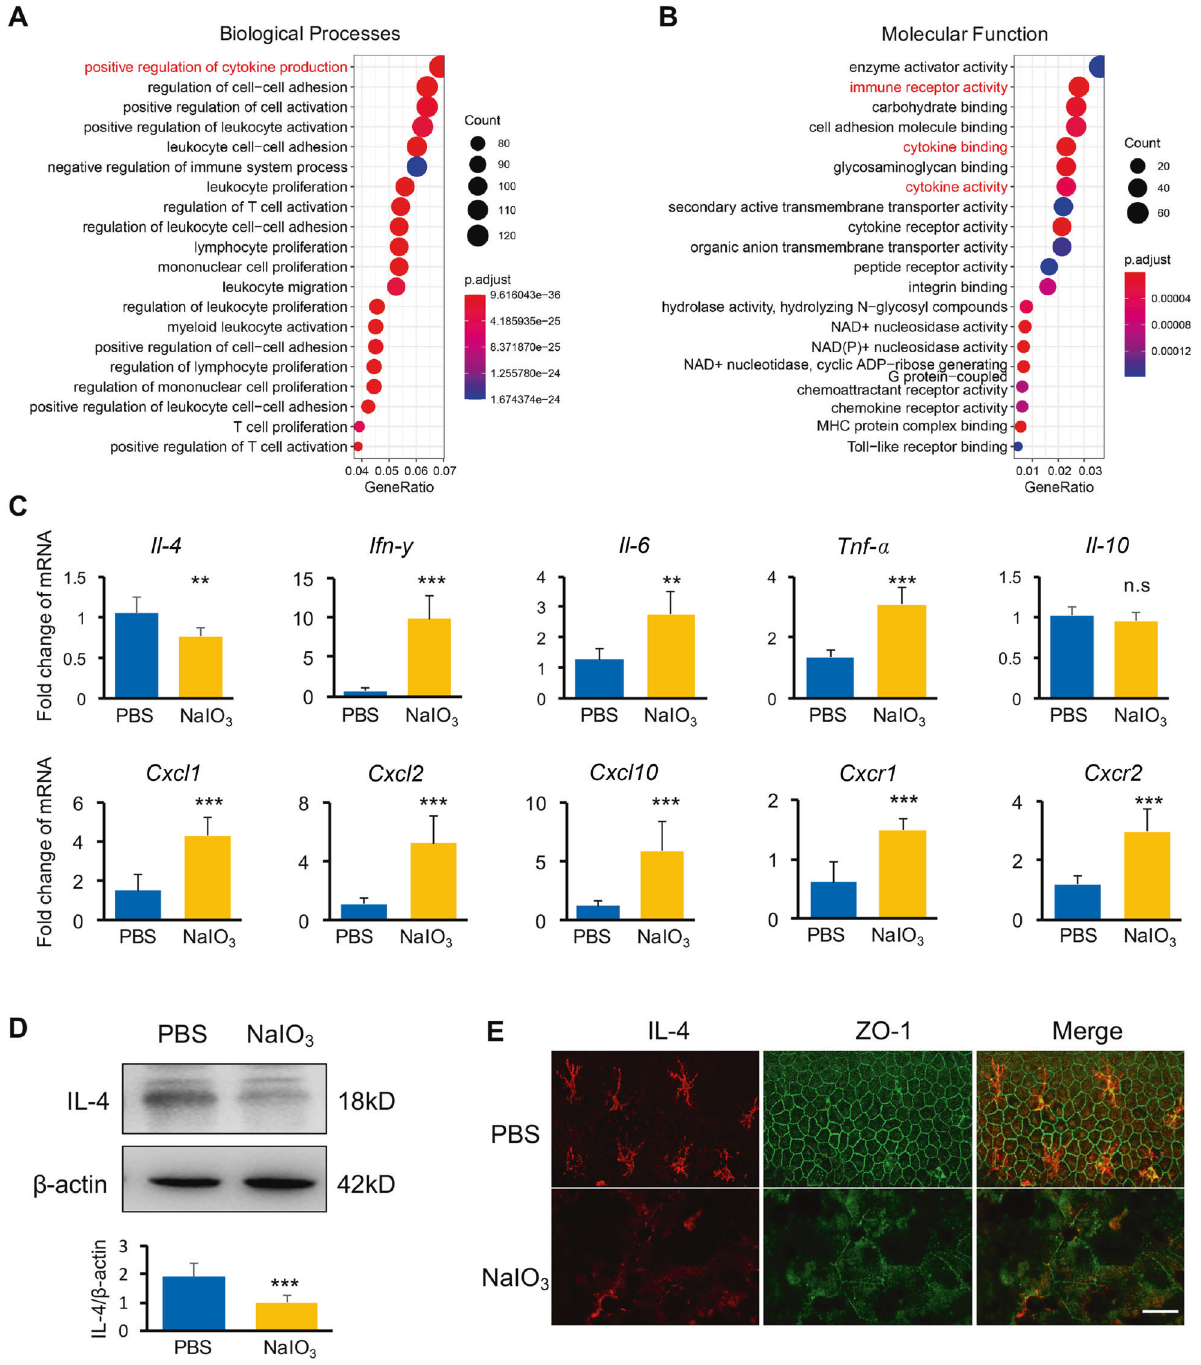
Fig. 1 NaIO 3 -induced degenerative retinae underwent in fl ammatory responses and displayed decreased IL-4 expression. A , B GO enrichment of the upregulated DEGseq in NaIO 3 -induced degenerative retinae showed the enriched differentially expressed mRNAs in biological processes ( A ) and molecular function ( B ). C qPCR analysis showed decreased mRNA levels of IL-4 in NaIO 3 -induced degenerative retina, while the pro-in fl ammatory cytokines and chemokines/chemokine receptors, including Ifn- γ , Il-6 , Tnf- α , Cxcl1 , Cxcl2 , Cxcl10 , Cxcr1 and Cxcr2 were signi fi cantly increased. The anti-in fl ammatory Il-10 had no signi fi cant difference between the NaIO 3 -induced retina and normal control, n = 3. D Western blotting analysis showed marked decreased IL-4 expression in the NaIO 3 -retinae in comparison to controls, n = 3. E Lack of IL-4 expression (red) and broken ZO-1-positive RPE barrier (green) were observed in the NaIO 3 -induced RPE fl at-mount sheet by immunohistochemistry analysis. Scale bar, 50 µm. n = 3. Data are shown as mean ± SEM, ** P < 0.01, *** P < 0.001, n.s: not signi fi cant, unpaired Student ’ s t -test in C and D decreased the levels of p-Nrf2 and IL-4R α in the cultured RPE cells, which were restored after IL-4 treatment (Fig. 4E). These results indicate that Nrf2 is probably implicated in the reparative and observed after IL-4 treatment (Fig. S3A, B). Consistently, in the protective role of IL-4. in vitro experiments, H 2 O 2 , a usually used oxidative stress inducer,